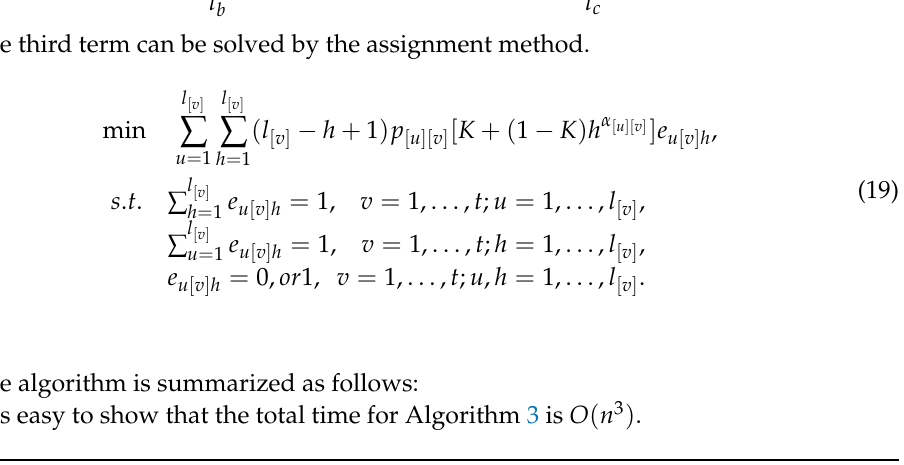
∑ l v | ∑ t C [ v u ][ v v = 1 u = 1